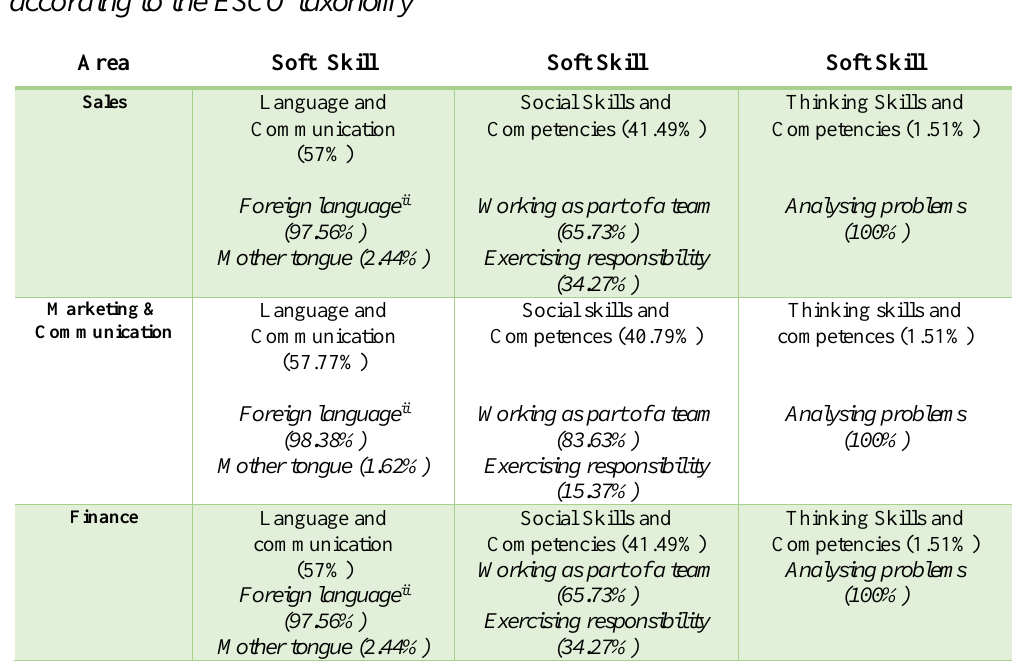
Table 3: Top 3 Soft Skills identified within the Vacancies and expressed according to the ESCO